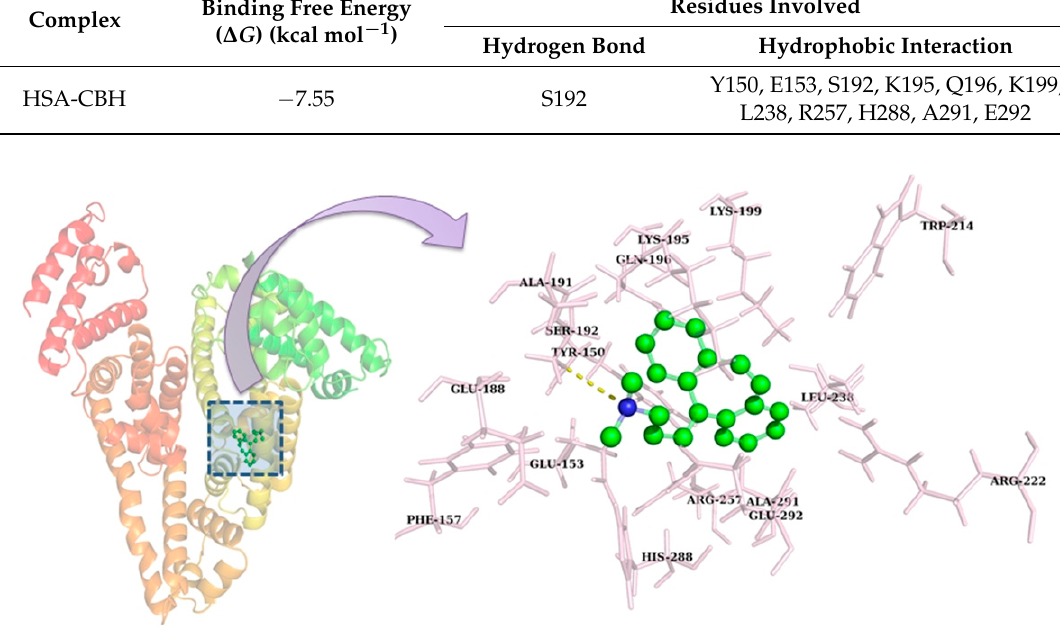
Figure 9. Docked conformation of CBH within the subdomain IIA (Sudlow site I) of HSA and the residues involved in accommodating CBH within its binding site.